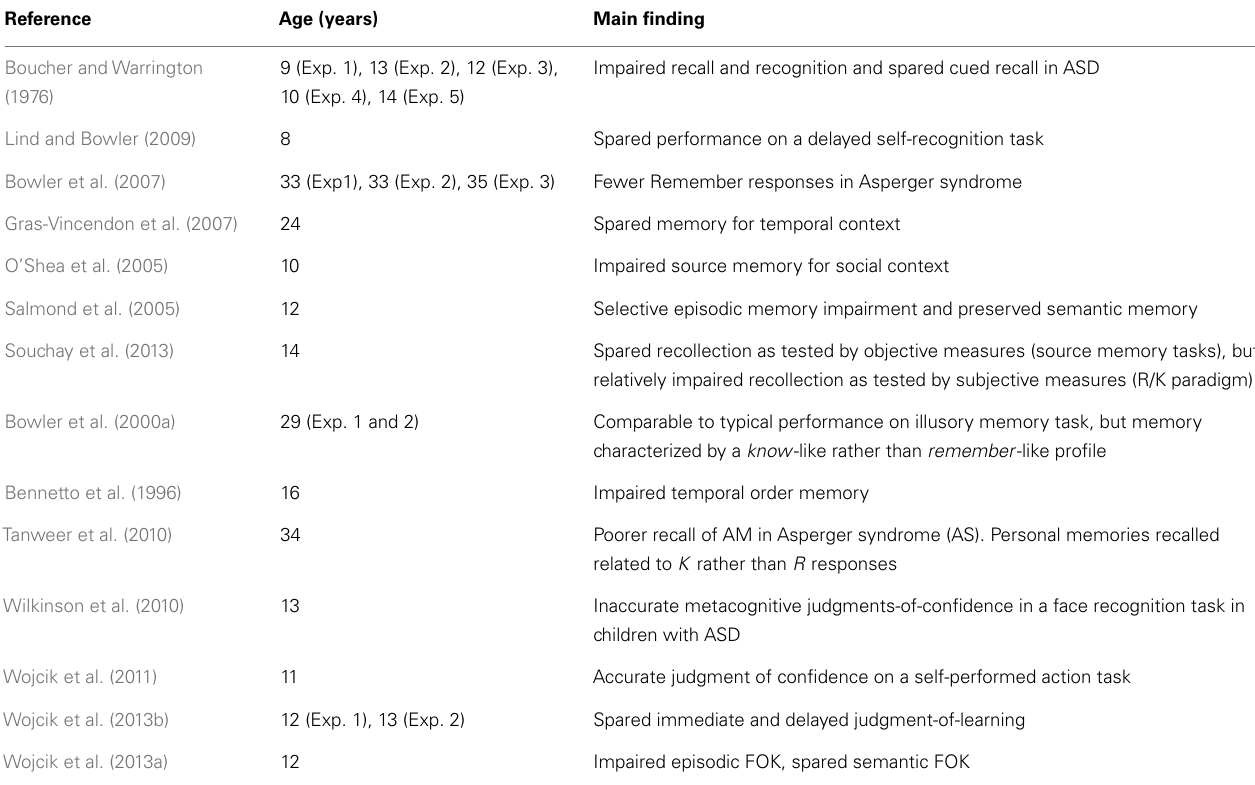
Table 2 | Key findings on episodic memory and metamemory inAutism